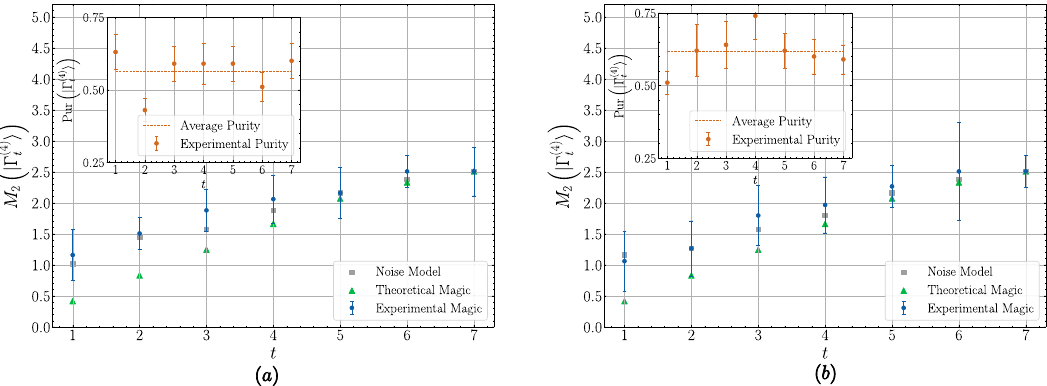
Fig. 5 Stabilizer 2-Rényi entropy for n = 4. Plot of the stabilizer 2-Rényi entropy for a ibmq_quito and b ibmq_casablanca. Both fi gures contain the experimental values (blue dots), the theoretical values (green triangles) of the magic for the desired pure state, and the noise model values (gray squares) of the magic for the mixed state prepared on the quantum processor. The values of the magic of the Γ ð 4 Þ t for t = 1, … , 7 are plotted as functions of the number of T -gates t in the doped random Clifford circuits, (see Supplementary Tables III and IV in Supplementary Note 4 for the data). See Fig. 3 for the preparation of such states. Both fi gures contain in the upper left corner the purity (orange dots) of the output state prepared on the quantum processor and its average value (dashed line). Here the number of resources N TOT ≡ N U × N M depends on the number of T -gates t thrown in the circuits as N TOT ¼ 2 A 4 þ B 4 ð 7 (cid:2) t Þ , where A 4 = 11.3 ± 0.3, B 4 = 0.49 ± 0.05, see Supplementary Table I in Supplementary Note 4 and Fig. 7 in “ Methods. ” Note that the experimentally observed magic can be — and typically is — higher than the theoretically predicted magic. See the caption of Fig. 4 for an